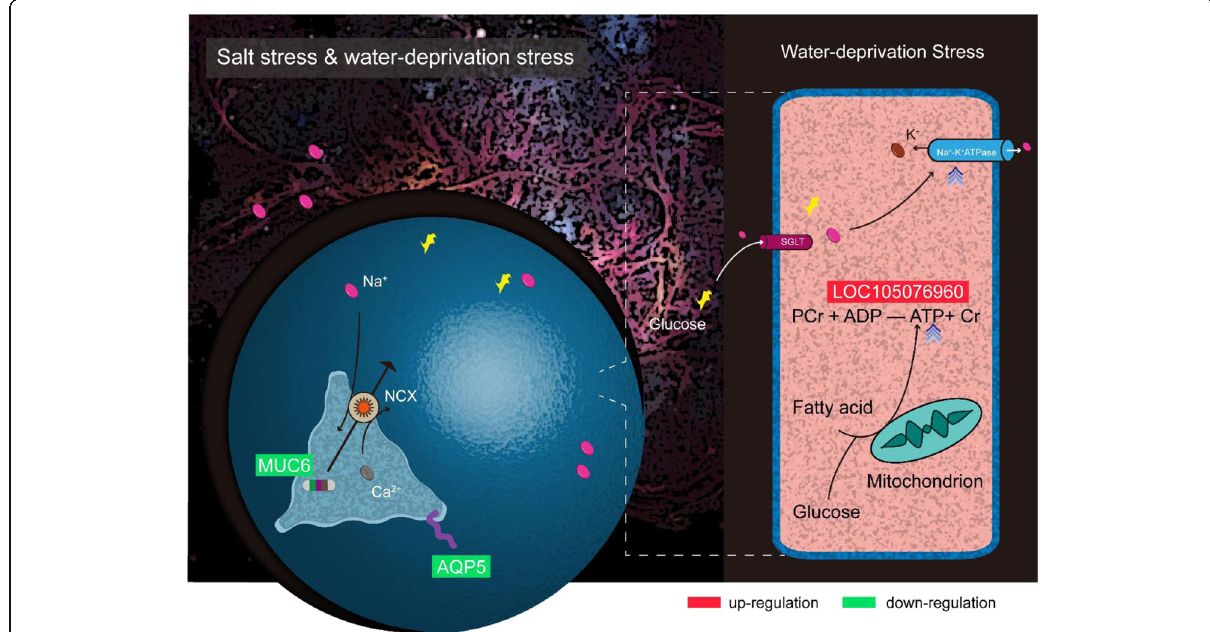
Fig. 5 Weakened sodium ion import and water loss with active energy buffer responding to ambient challenge in camel